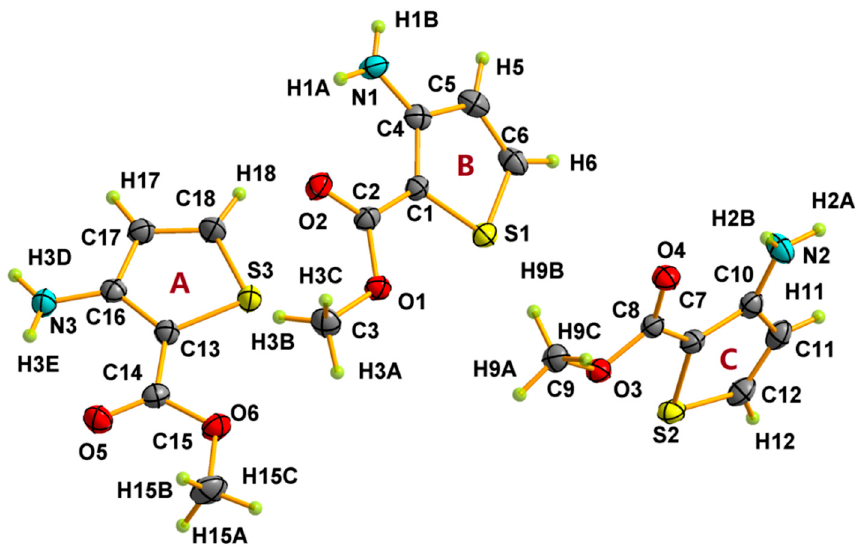
Figure 1. Asymmetric unit and atom-labeling for matc. Atomic displacement ellipsoids are depicted at the 50% probability level. A, B, and C in orange designate the three different molecules in the asymmetric unit.